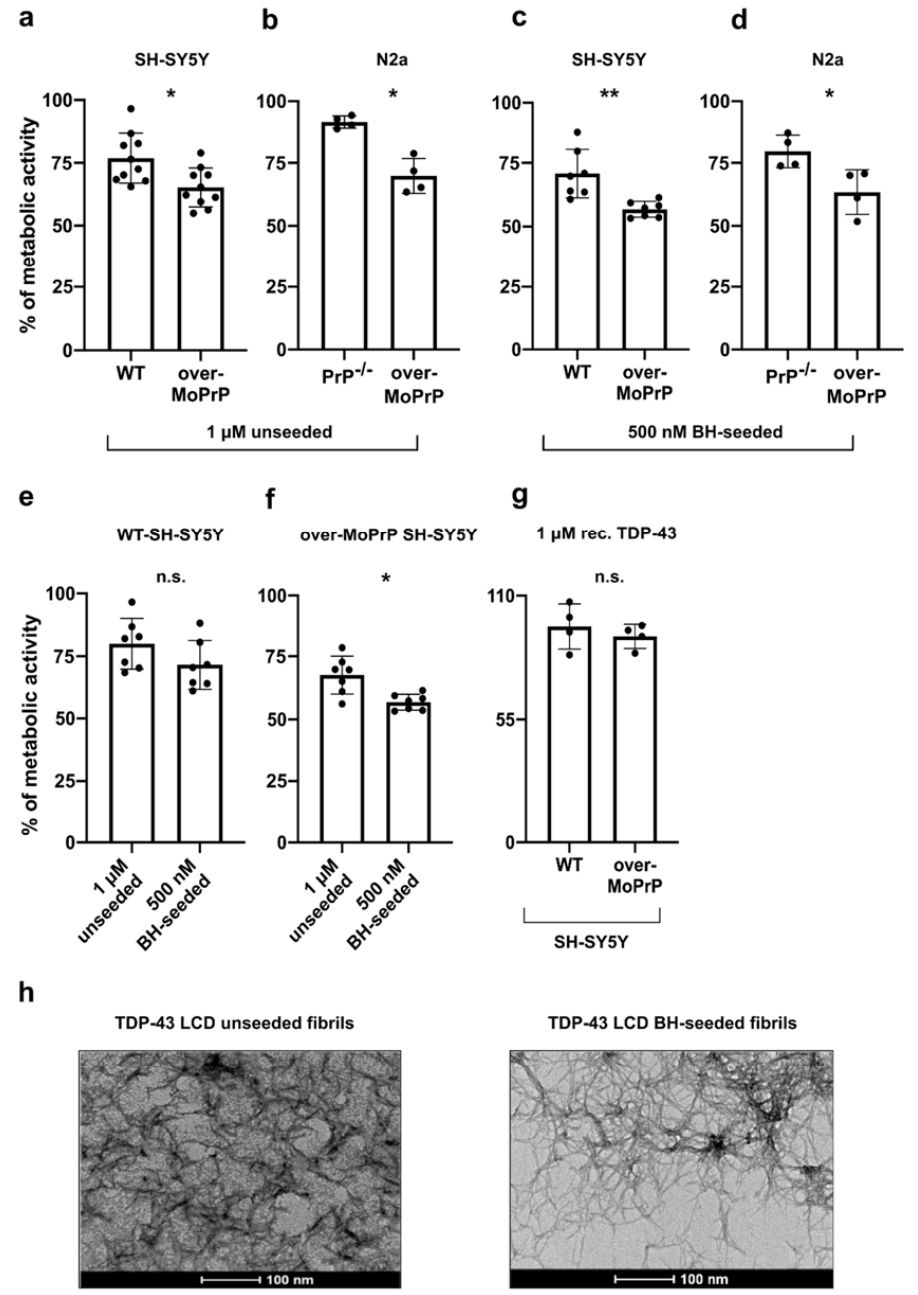
Figure 2. PrP C on the cell surface increases TDP-43 LCD fibril toxicity in SH-SY5Y and N2a cells. Cell vitality of WT or over-MoPrP SH-SY5Y and PrP -/- or over-MoPrP N2a cells. after treatment with ( a , b ) 1 µ M unseeded or ( c , d ) 500 nM BH-seeded TDP-43 LCD sonicated fibrils; comparison of the toxic effect of unseeded and BH-seeded TDP-43 LCD fibrils on WT ( e ) and over-MoPrP ( f ) cells; ( g ) cell vitality of WT and over-MoPrP SH-SY5Y cells after treatment with 1 µ M recombinant monomeric TDP-43 LCD; data were evaluated with Mann-Whitney test; * p < 0.05; ** p < 0.01; n.s.: not significant. Cell vitality was evaluated as the percentage of treated cells with an active metabolism at the MTT assay compared to control cells treated with 1X PBS (corresponding to the 100% value of metabolic activity). Data in the graphs are reported as mean ± SD; each dot represents the mean value for the six replicates of each independent experiment; ( h ) transmission electron microscopy analysis of TDP-43 LCD unseeded and BH-seeded fibrils collected when the reaction reached its